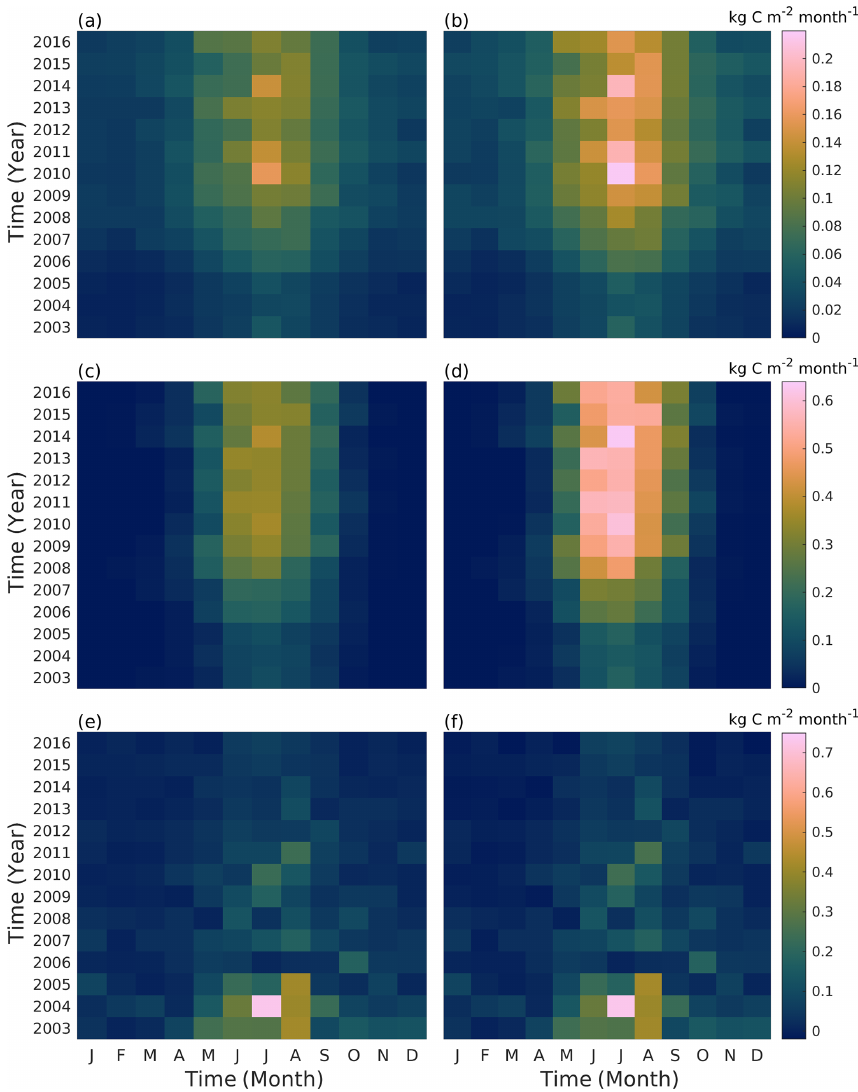
Figure 8. Simulated monthly street tree respiration (a, b) , photosynthesis (c, d) , and soil respiration (e, f) at the Tilia (a, c) and Alnus (b, d) sites during the simulation period